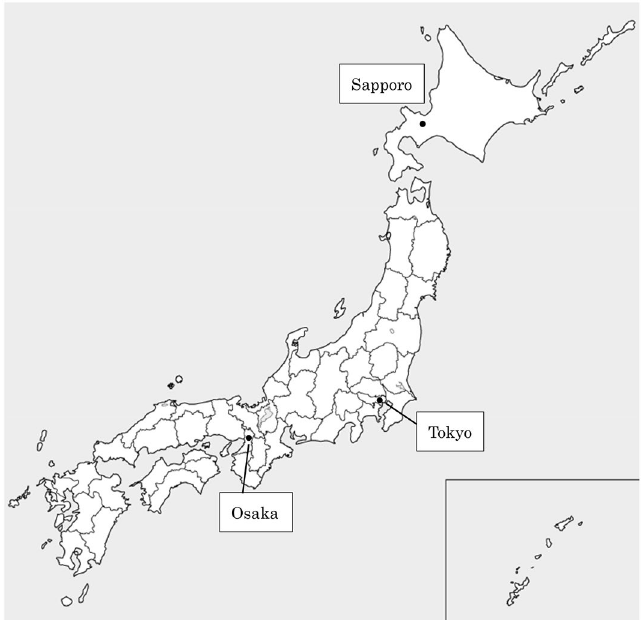
Figure 1. Map of Japan. In the present study, the 47 prefectures of